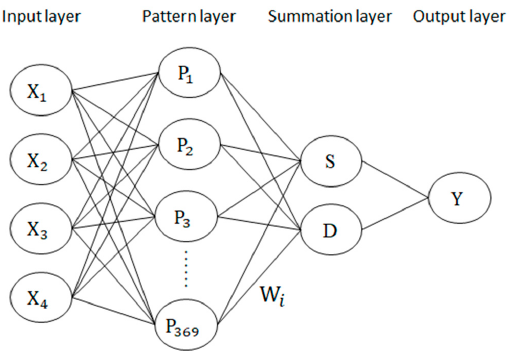
Figure 1. General Regression Neural Network architecture used for a Wafer-Handling Robot Arm.